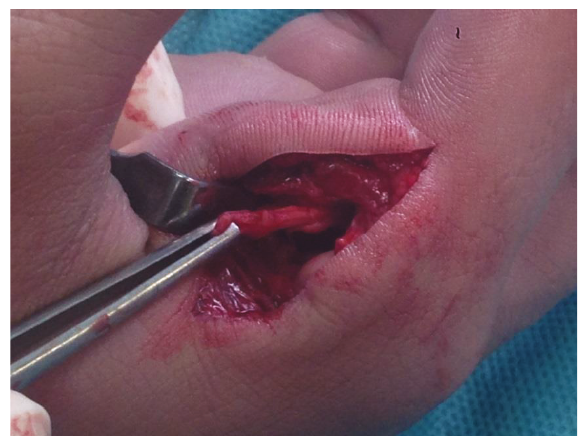
Figure 5: Interposition of the volar plate blocking the reduction.